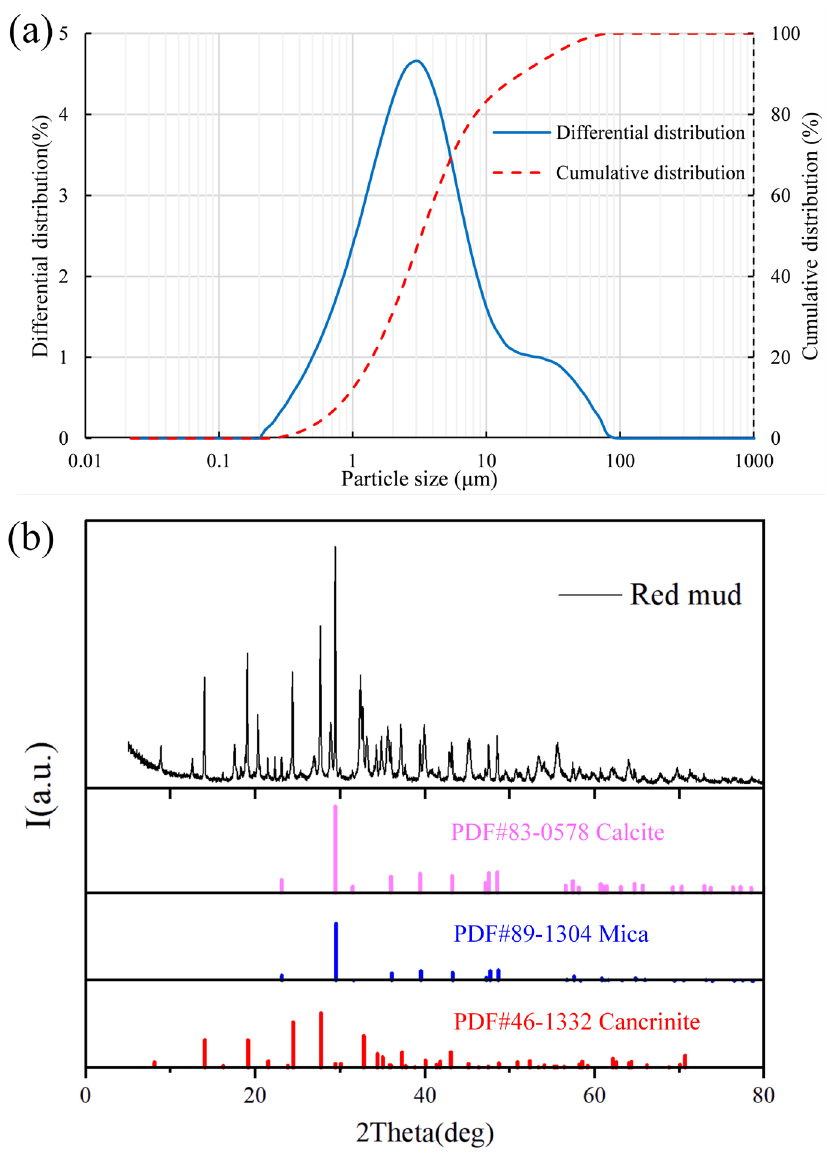
Table 1. Physical parameters of the red mud.